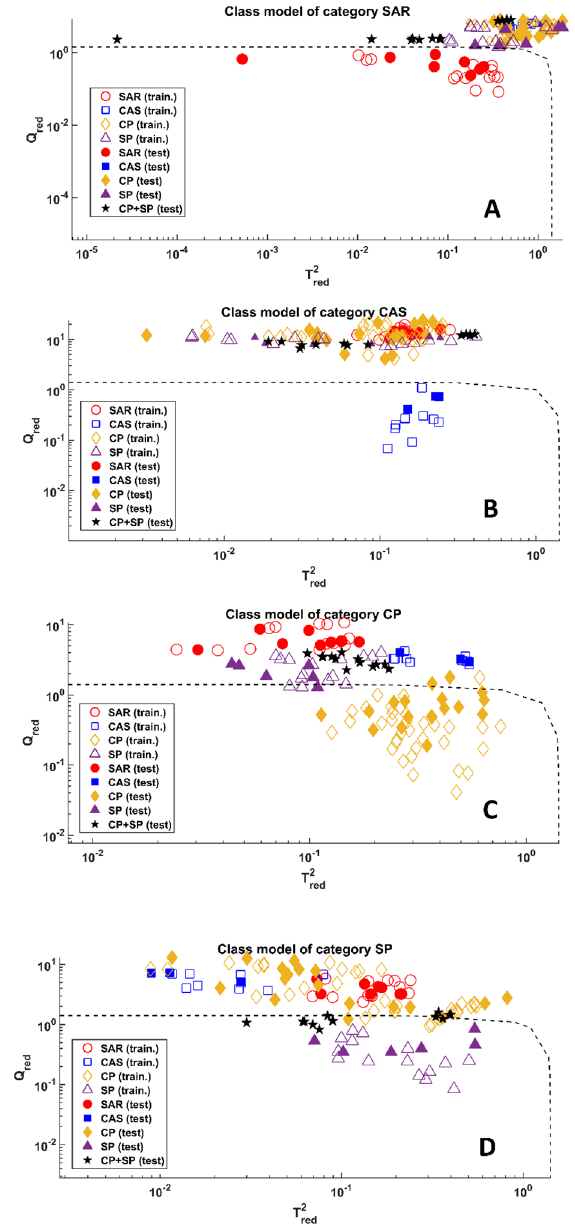
Figure 3. SIMCA analysis, projection of samples onto the T 2 and Q red space. ( A ) Model of Sardinia red Class. ( B ) Model of Cascia Class. ( C ) Model of Citt à della Pieve Class. ( D ) Model of Spoleto Class. Legend: red dots—Sardinia; blue squares—Cascia; mustard diamonds—Citt à della Pieve; purple triangles—Spoleto; black stars—mixtures (SP +